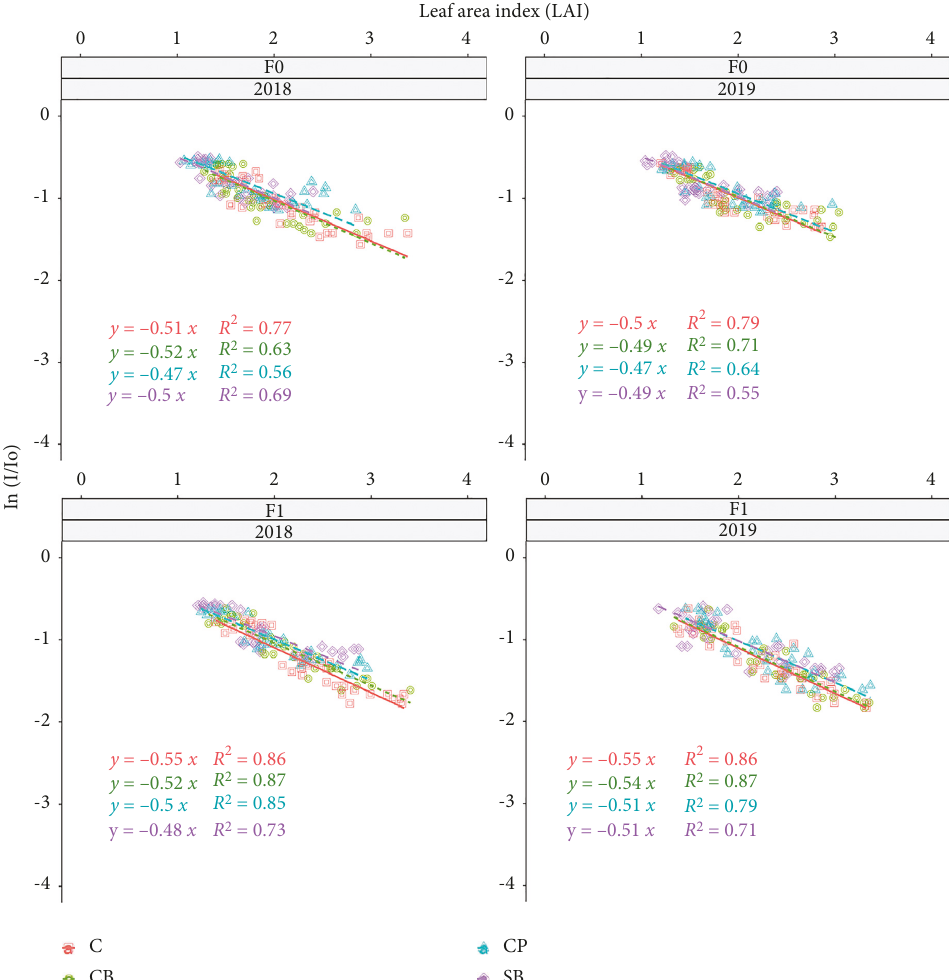
Figure 3: Effects of fertilizer and year on the cassava canopy extinction coefficient (k) under soybean (SB), common beans (CB), and cowpea (CP)